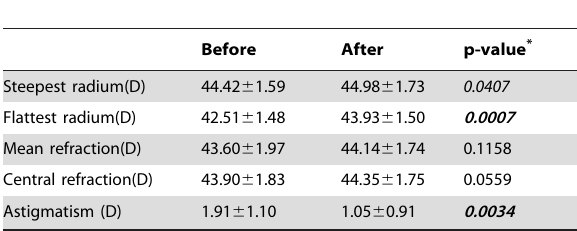
Table 2. Changes in corneal topographic refraction before and after pterygial